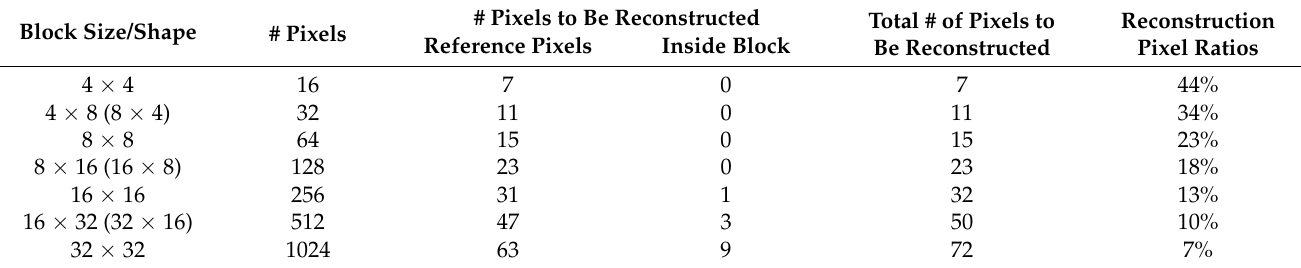
Table 1. The number of pixels to be reconstructed for the block sizes.